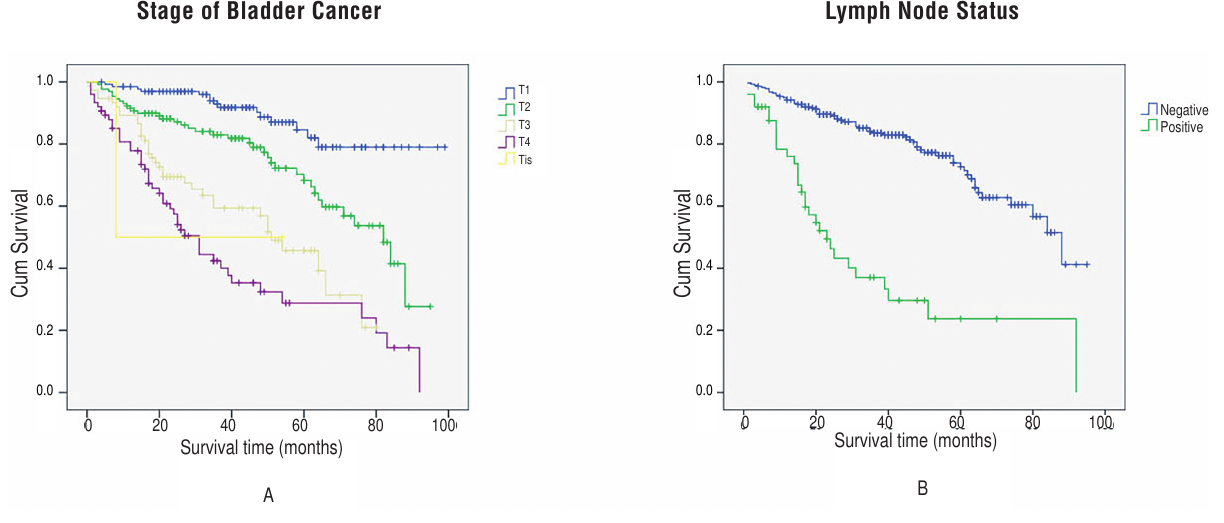
Figure 1 - Estimated Kaplan-Meier overall survival stratified by stage of bladder cancer (a) and lymph node status (b) (all P